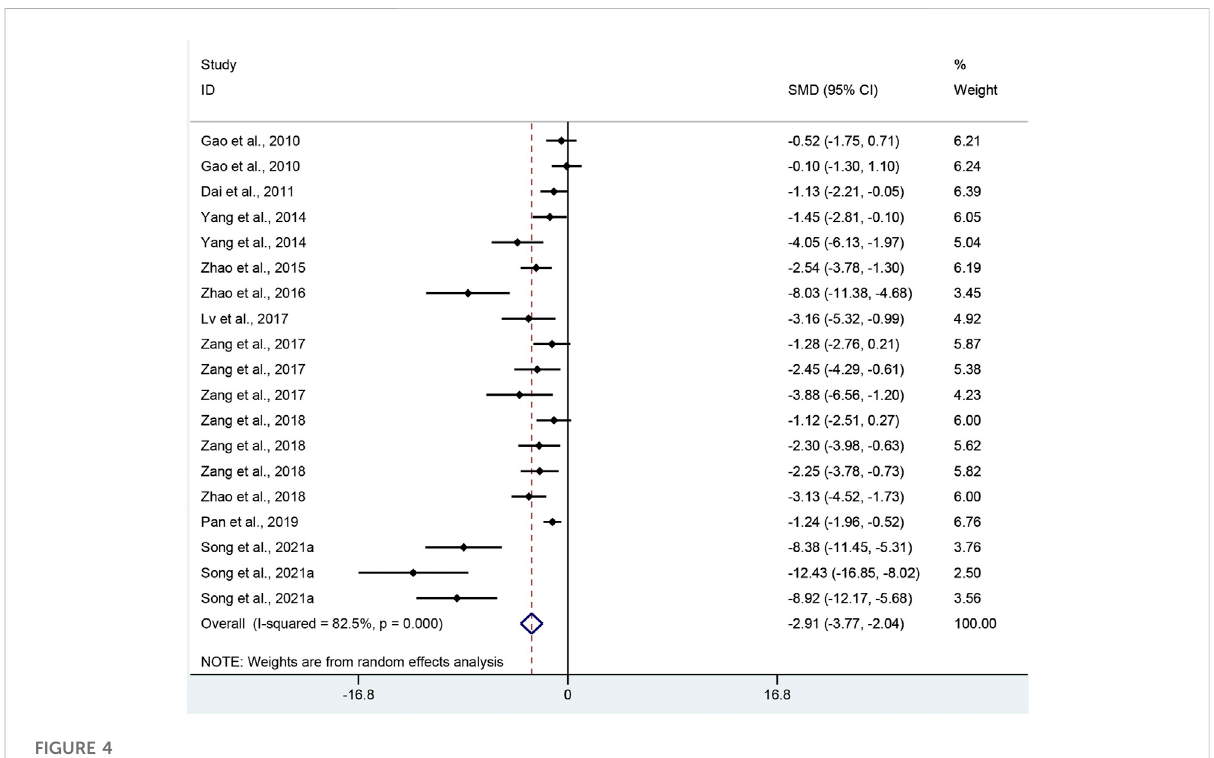
FIGURE 4 Pooled estimate of CHS with